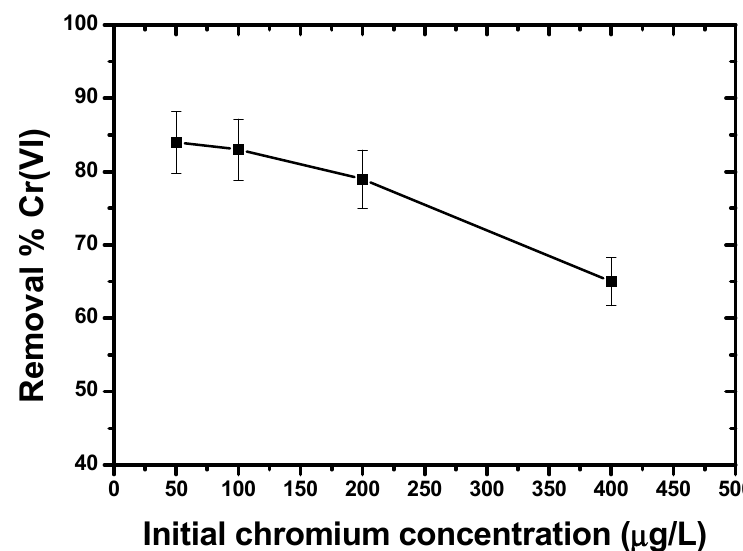
Figure 4. Influence of starting hexavalent chromium concentrations on Cr(VI) removal. Experimental conditions: initial Cr(VI) concentration 50, 100, 200, 400 μ g/L, flocculant dose 0.5 mg/L, linear velocity 4 m/h, pH 7.3.